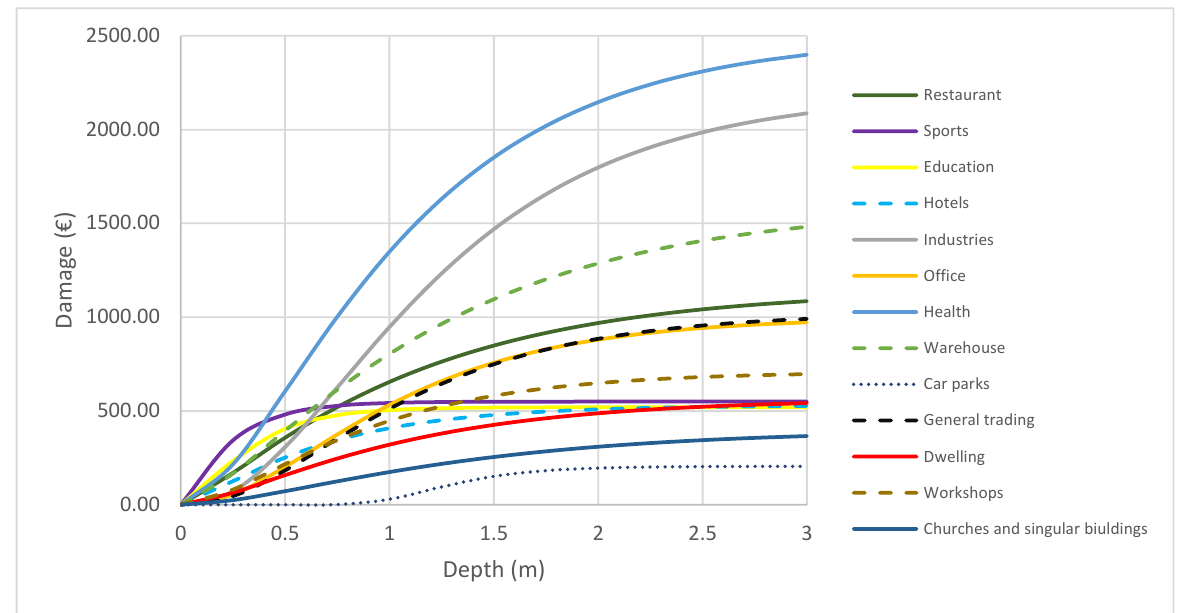
Figure 10. Damage – depth curve for the case study. Figure 10. Damage–depth curve for the case study.